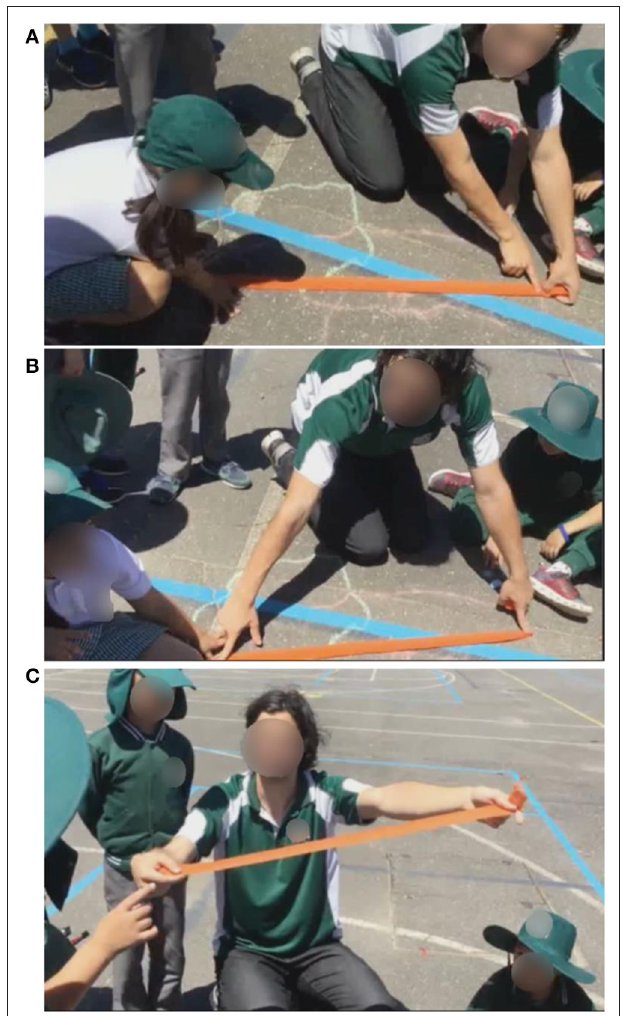
FIGURE 2 | (A) Are you happy with that Moira? (Moira was checking the process). (B) One person’s marked the start and one person’s marked